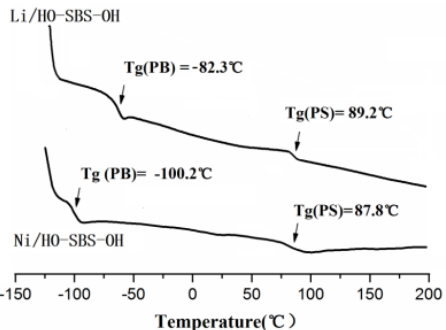
Figure 6. Differential scanning calorimetry (DSC) data of Ni/HO – SBS – OH and Li/HO – SBS – OH.